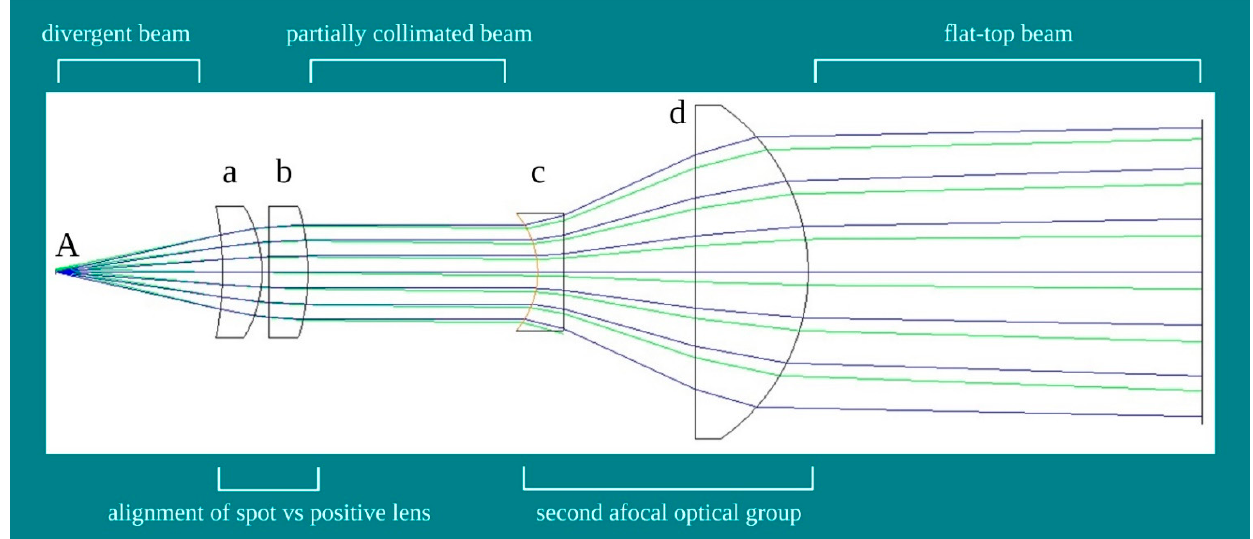
Figure 2. Schematic design of the flat-top hand-piece. ( A ) = fibre’s spot delivering laser light; ( a , b ) = collimating lens; ( c , d ) = couple of lens to generate an afocal optical group.